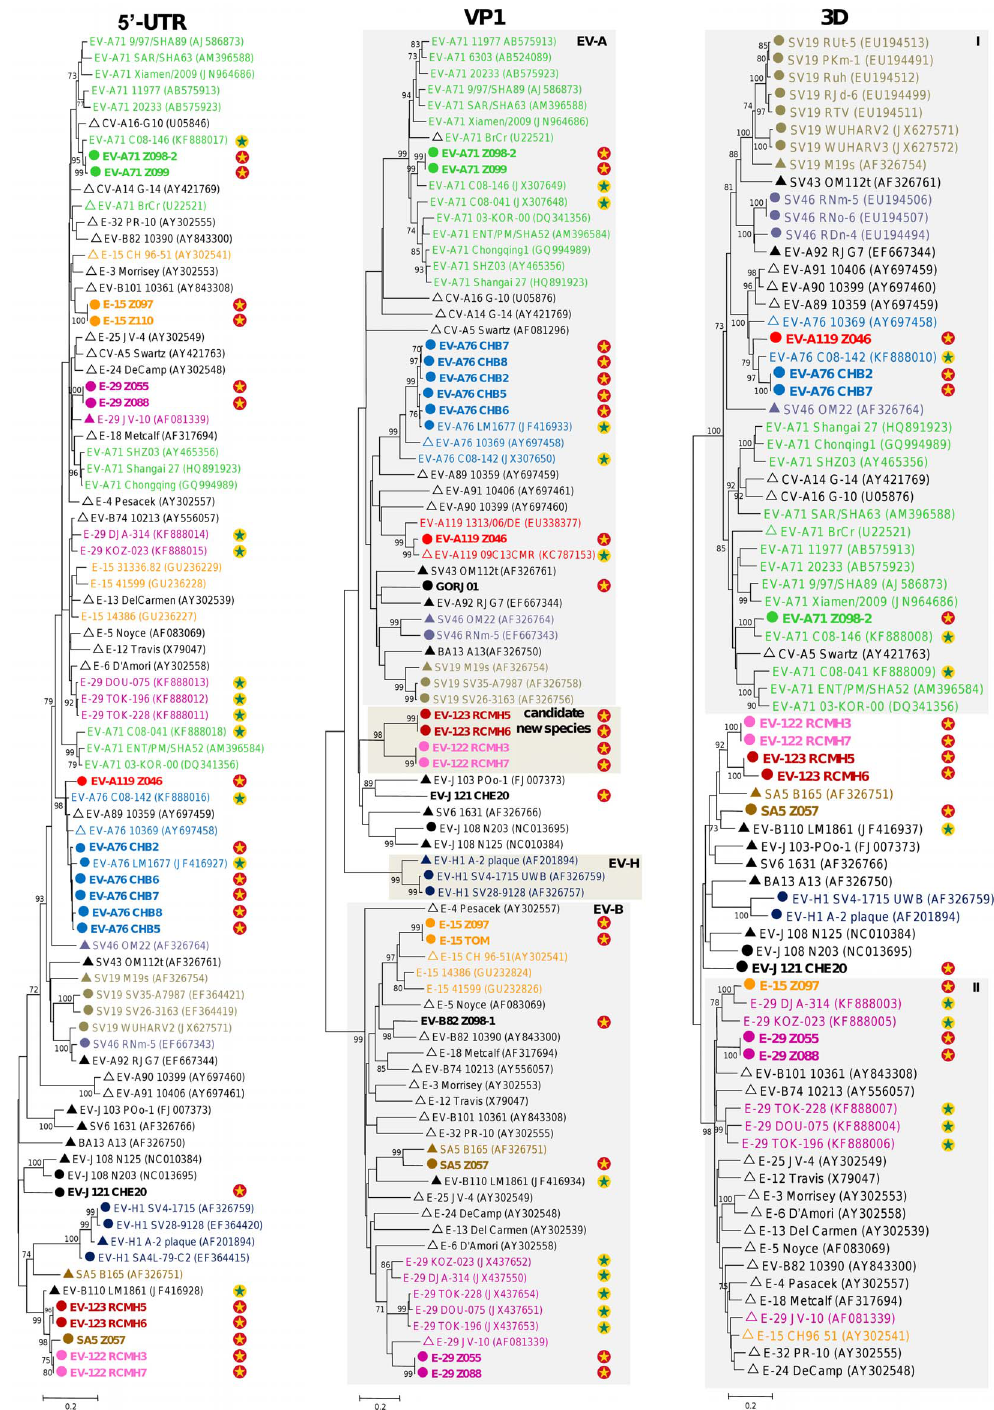
Figure 5. Phylogenetic relationships among the 5 9 UTR, VP1 and 3D pol sequences of enteroviruses from human and non-human primates. Only non species C enteroviruses were considered in these trees. The 5 9 UTR, VP1 and 3D pol trees were based on the alignments of partial sequences (positions according to EV-A71 strain BrCr numbering: 193–430 for 5 9 UTR, 2615–2903 for VP1 and 6034–6377 for 3D pol regions). Only non species C enteroviruses whose partial or complete VP1 sequences could be generated were considered in this comparative analysis. Prototypes N strains originating from non-human primates ( m ) or humans ( D ) are indicated. All other non-human primates strains from previous studies are ) and those from this study are color-coded according to virus types. Non-human primates-derived viruses distinguished by black circles ( characterized in this study are further highlighted by yellow stars whereas green stars specify viruses previously identified in Cameroon either from humans or non-human primates.